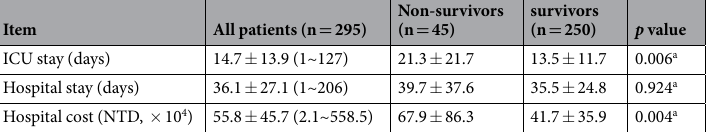
Table 3. Outcomes of different unplanned extubation groups. Expressed as mean ± SD (range); NTD = new Taiwan dollars. a The Mann-Whiney U test was used owing to not being normally distributed.